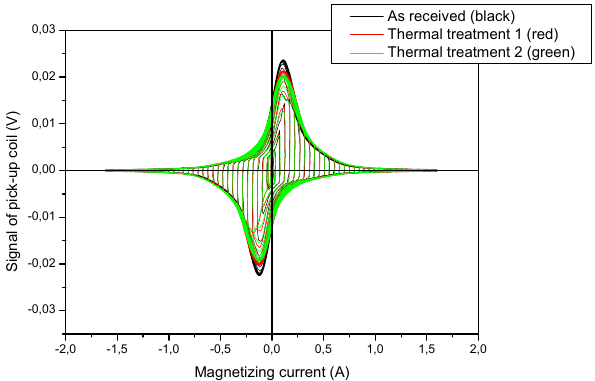
Figure 3. Measured permeability loops of the three (as received and thermally treated) 15Kh2NMFA samples.